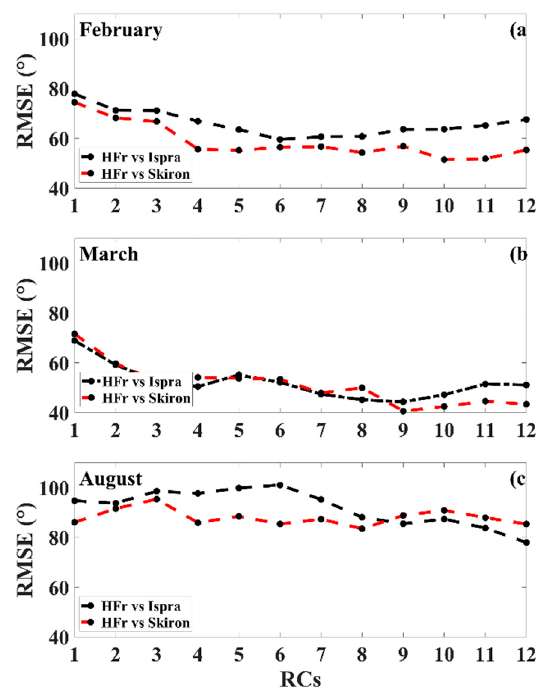
Figure 8. RMSE relative to the comparison between HFr and ISPRA data (black dashed line) and between HFr and SKIRON/Eta data (red dashed line) for the different RCs shown for the first winter event occurred during 6–8 February 2009 ( a ), the second winter event during 3–6 March 2009 ( b ) and the summer event 4–6 August 2009 ( c ).